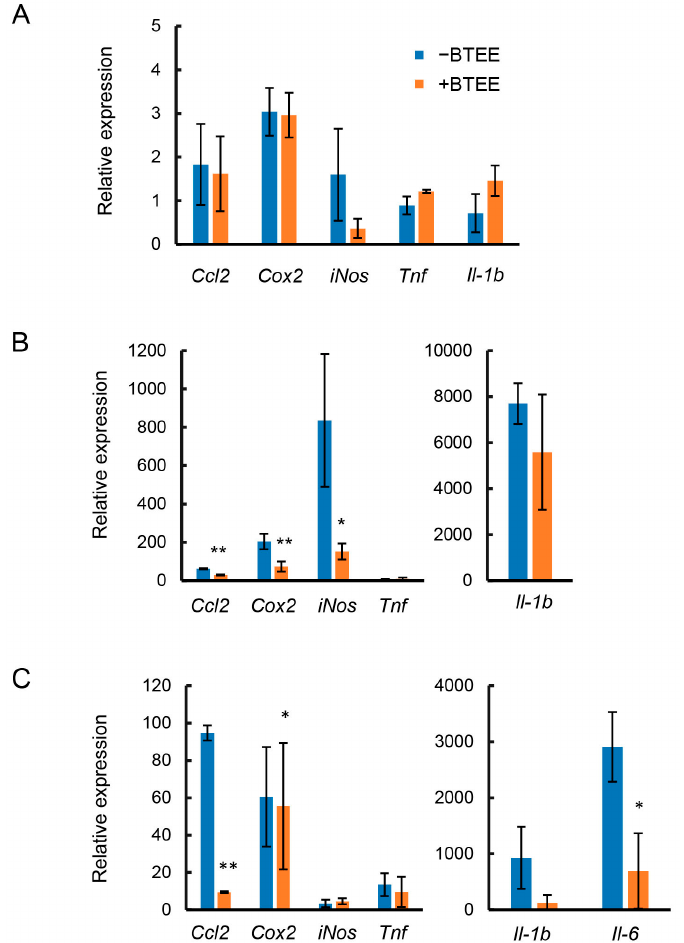
Figure 2. Effects of BTEE on the mRNA expression of inflammatory mediators. Cells were treated with or without BTEE at concentrations of 0.2 mg/mL for 24 h. After treatment, cells were activated with LPS (1 ng/mL) for ( A ) 0 h, ( B ) 6 h, and ( C ) 17 h. The mRNA expressions of pro-inflammatory mediators were determined by RT-PCR. Values are expressed as the mean ± SD of triplicate experiments. Significance is indicated as * p < 0.05 or ** p < 0.01.